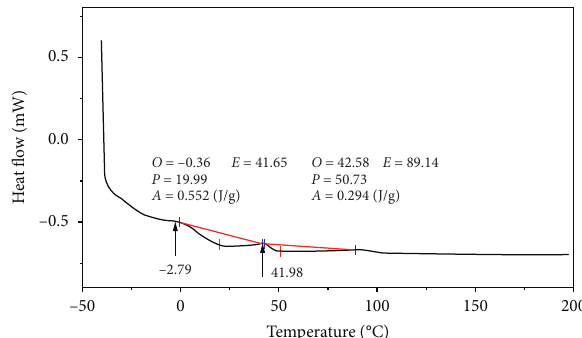
Figure 8: DSC results of neat asphalt binder.